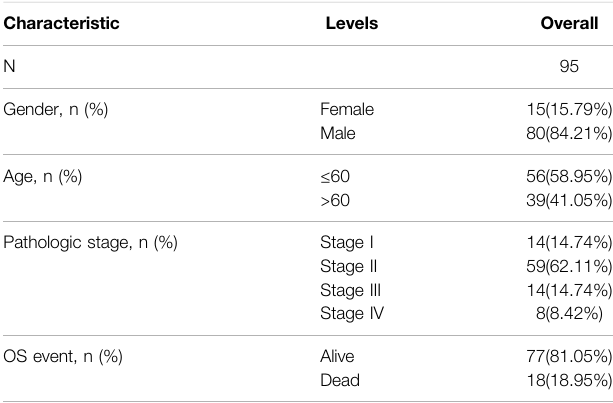
TABLE 2 | Clinical data of patients with esophageal squamous cell carcinoma in TCGA. Characteristic